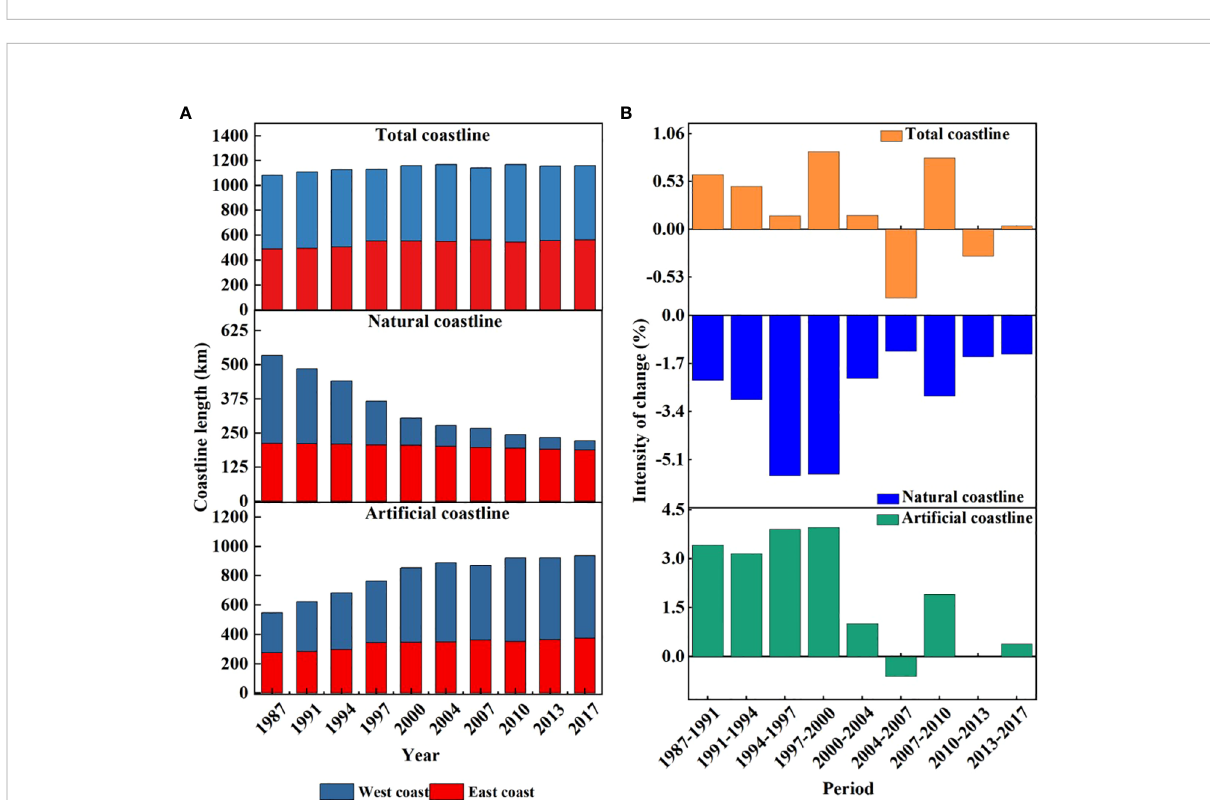
FIGURE 4 Variation in the coastline length (A) and length variation intensity (B) of natural, arti fi cial and total coastlines in the Pearl River Estuary from 1987 to